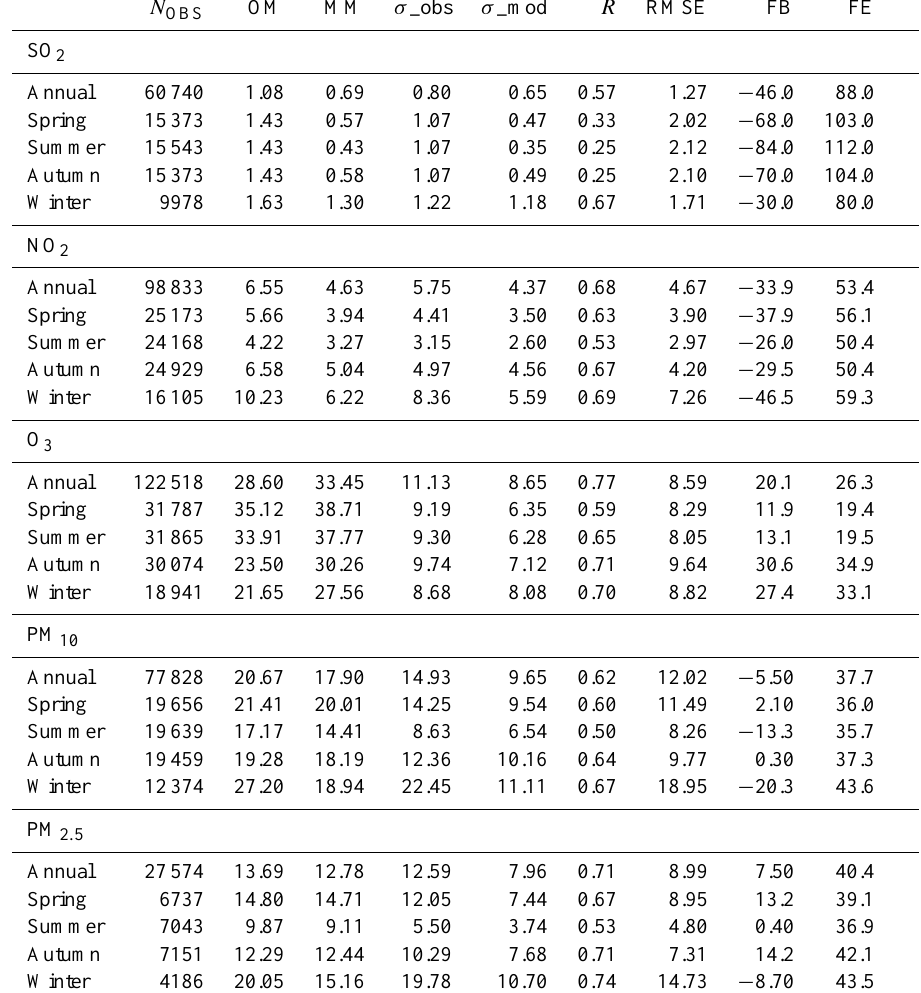
Table 4. Annual and seasonal scores calculated using the whole RB AirBase set of stations. The statistics are: the OM, the MM, the standard deviation of the observations ( σ _obs) and modelled values ( σ _mod), the correlation coefficient ( R ), the RMSE, the FB (%) and FE (%). N OBS is the number of observations. The units of the statistical indexes for each pollutant are reported in Table 3. R is unitless. N